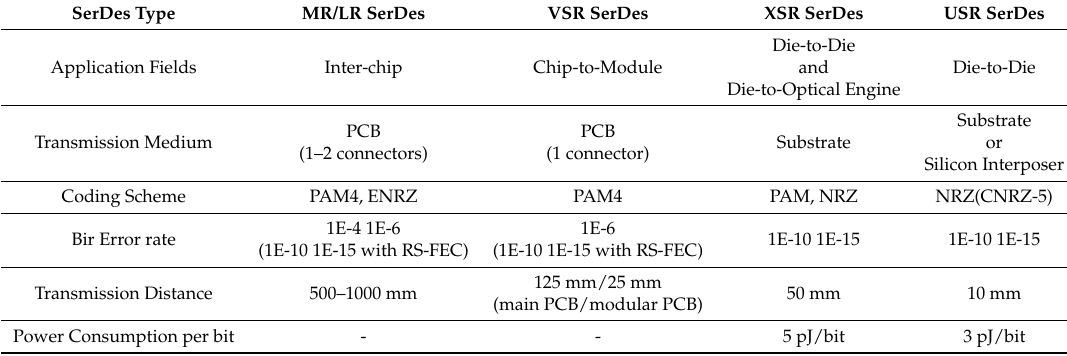
Table 2. Comparisons among different types of OIF 56 G